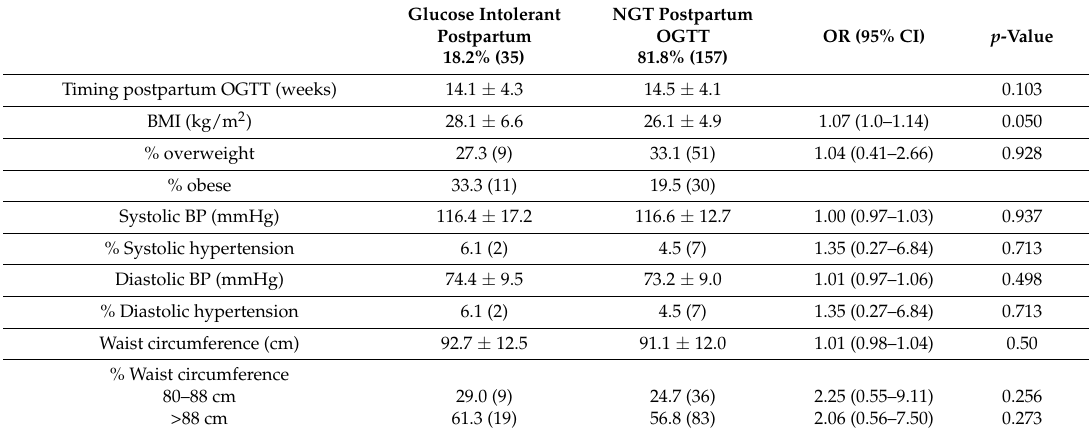
Table 1. Characteristics of women with glucose intolerance compared to normal glucose tolerant women at the time of the OGTT postpartum. Glucose Intolerant